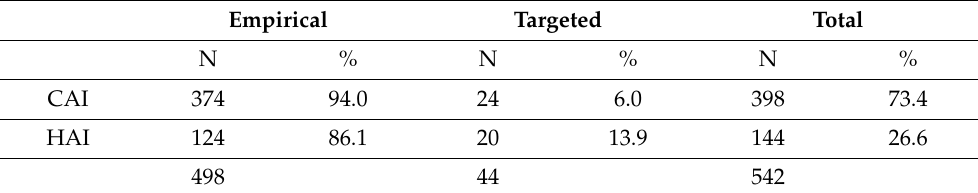
Table 3. The proportion of antimicrobials for empirical versus targeted treatment per therapeutic use (CAI or